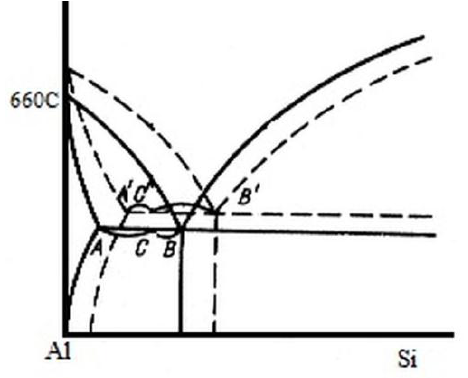
Figure 2. Al-Si phase diagram. The solid lines comprise the equilibrium phase diagram [24]. The dashed lines were added to the diagram after GDT application. This is a new image obtained by authors; new dashed lines build on a known phase diagram.